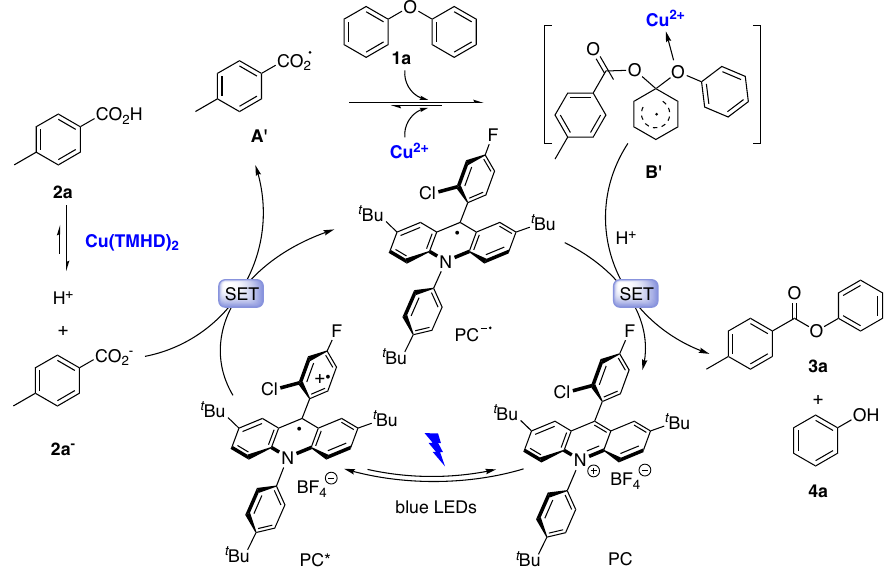
Fig. 8 Proposed mechanism for the acidolysis. A selective electrophilic attack of the generated aryl carboxylic radical on the electron-rich aryl ring of the diphenyl